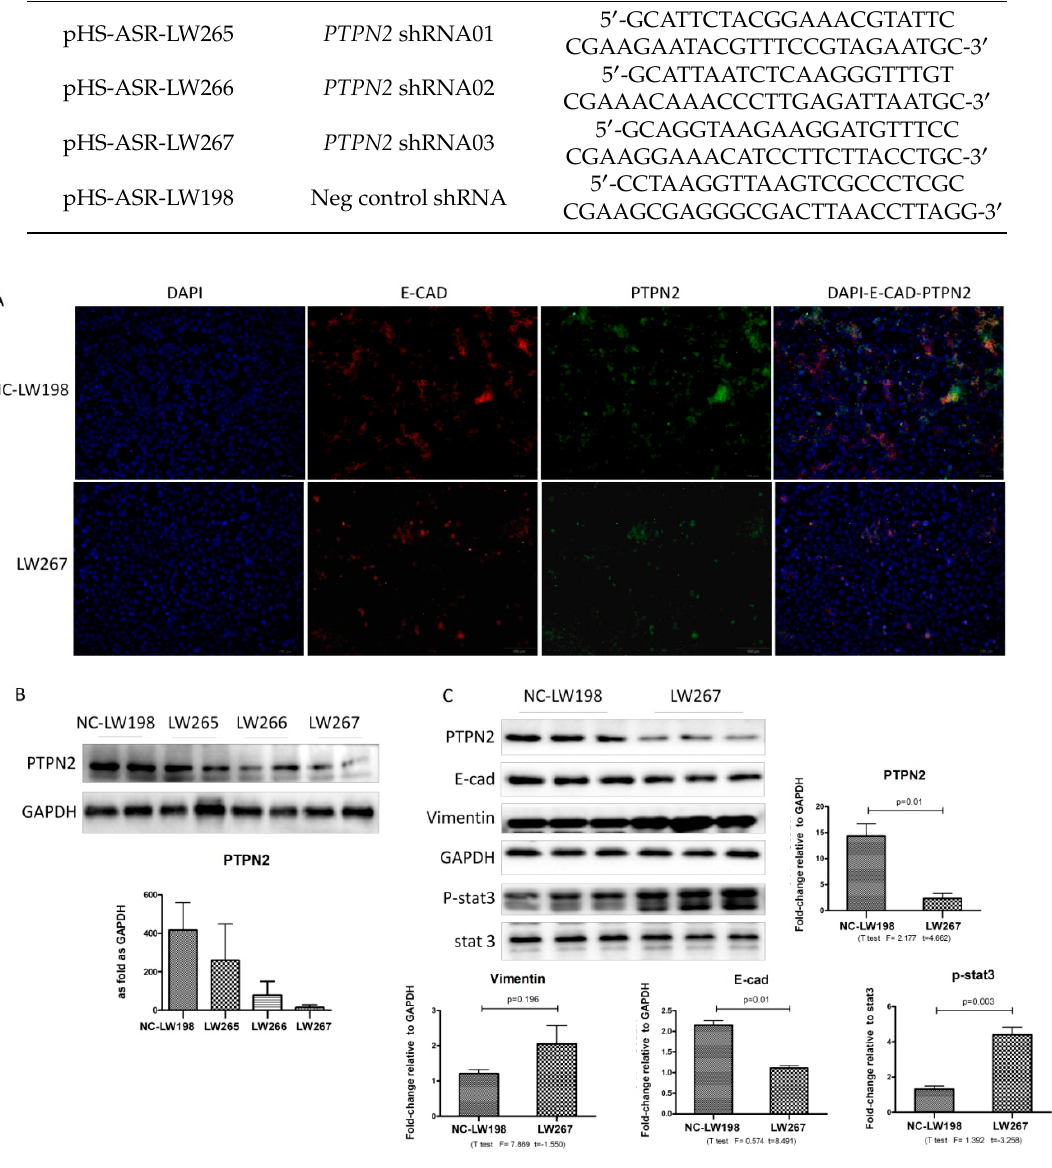
Figure 7. E ff ect of PTPN2 gene silencing on MLE-12 cells. ( A ) Immunofluorescent staining of PTPN2 and E-cad expression for the PTPN2 gene silencing (LW267) and negative control (NC-LW198) groups; Scale bars: 100 µ m. ( B ) E ff ectiveness of di ff erent shRNA probes in the expression of PTPN2. ( C ) Western blot and corresponding densitometry data of the expression levels of PTPN2, E-cad, Vimentin, and p-STAT3 in the NC-LW198 and LW267 cells. The relative expressions were expressed as the fold-change of specific bands in the negative control group. Bar graphs are the mean ± SD of two separate experiments. Statistical analysis was performed using a t -test with